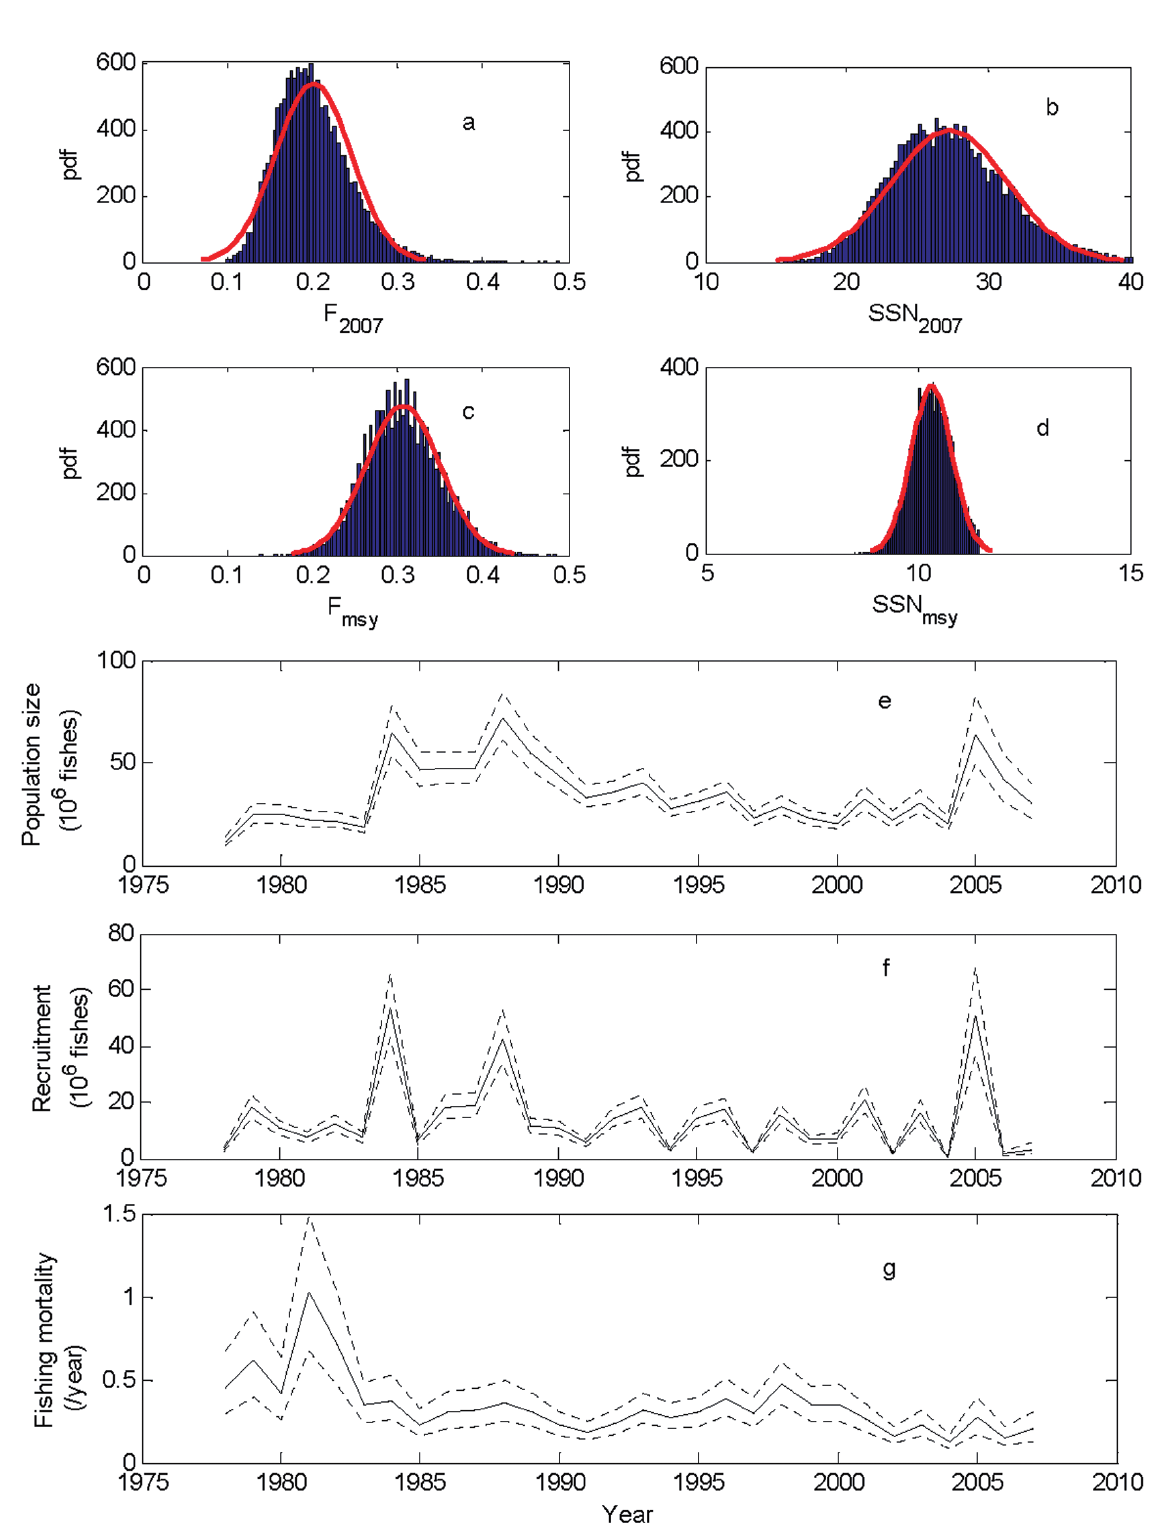
Fig . 4. – Posterior probability distributions of (a) fishing mortality, (b) abundance, (c) estimated F fishery in 2007. Normal distribution fits (red lines) are overlaid on the plots. Time series of mean and 95% credible intervals from the posterior distributions of (e) population size, (f) recruitment and (g) fishing